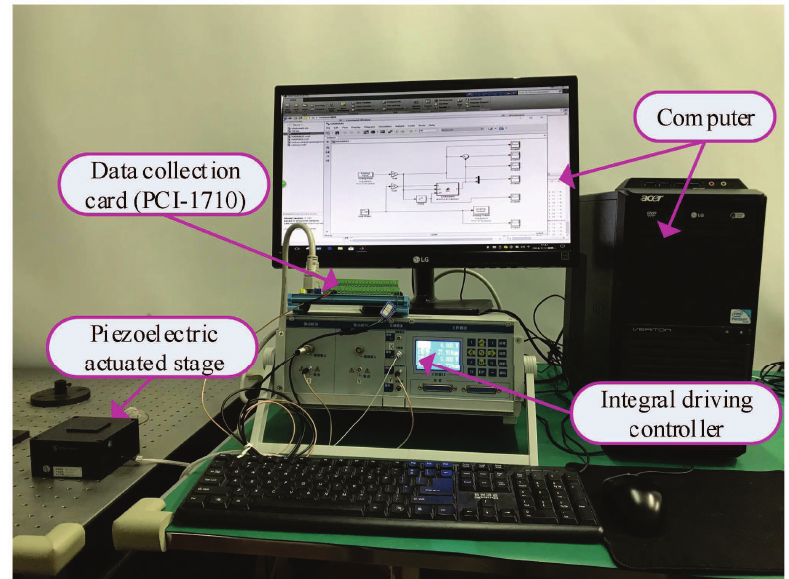
Figure 5. Picture of the piezoelectric actuated stage experimental